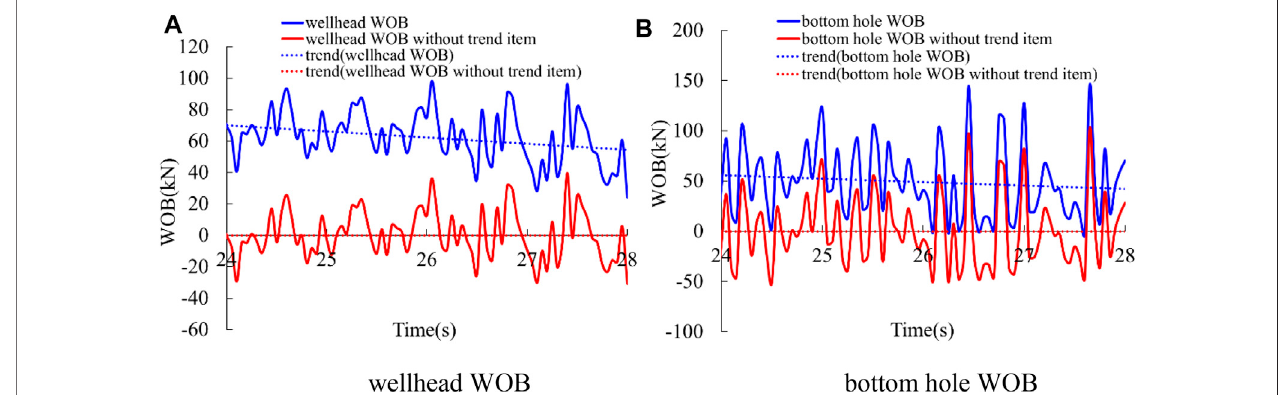
FIGURE 14 | Original signal and signal without trend item of wellhead WOB and bottom hole WOB.